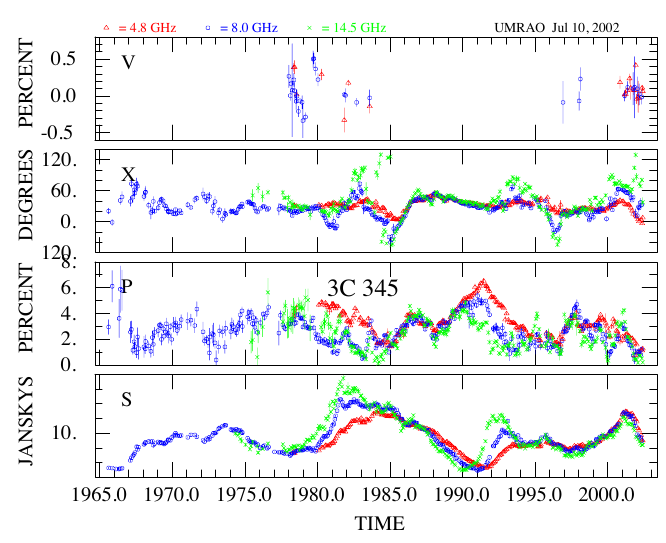
Figure 1. From bottom to top: Long-term total flux density (S), fractional linear polarization (P%), electric vector position angle (EVPA or χ ), and fractional circular polarization (V%) for the quasar 3C 345. The three centimeter-band frequencies are symbol and color coded as denoted at the top left. Polarity changes in V occurred at both 4.8 and 8.0 GHz in 1978–1984 contemporaneous with a large self-absorbed outburst in total flux